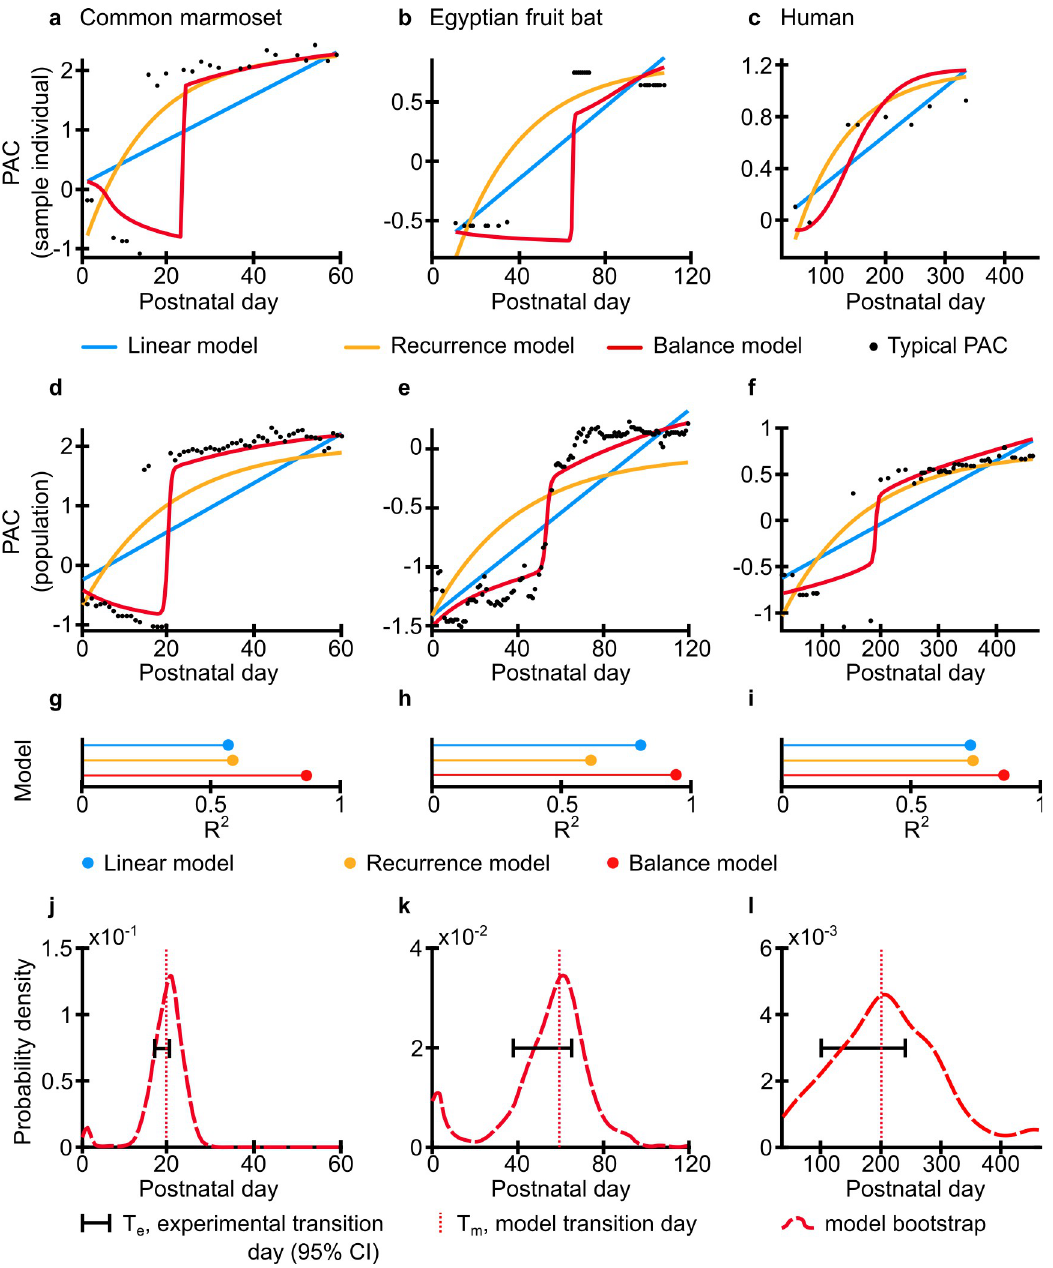
Fig 2. The energy-information balance model most successfully reproduces the transition day between two states for different species. Analysis made using common marmoset in the left column, Egyptian fruit bat in the middle column, and human in the right column. a-c. Best model fit for individuals of the three species. Notice that for the bat dataset, the data collection was from different recording periods instead of a single longitudinal experiment; this lead to some gaps in the data. The black dots are the typical PAC, i.e., a moving average calculated from the experimental data per day of recording (see Methods - Estimation of typical PAC per day). Blue lines are the best fit for the linear model, orange lines are the best fit for the recurrence model and red lines are the best fit for the balance model. d-f. Model fitting for the population for the three different species. g-i. Comparison between the best R 2 for each model. j-l. Comparison of transition date predicted by the balance model and calculated from experimental data. Both transition dates were calculated by fitting a sigmoid to the values, and distributions were obtained via bootstrap.